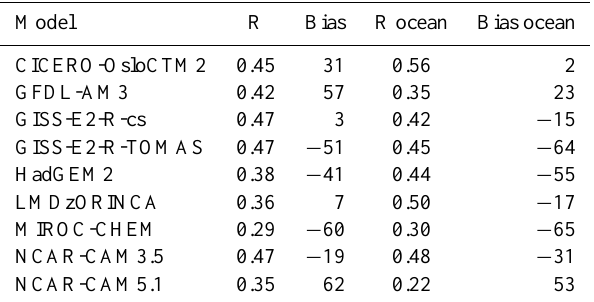
Table 3. Comparison of models with MODIS fine mode AOD over all areas and over ocean